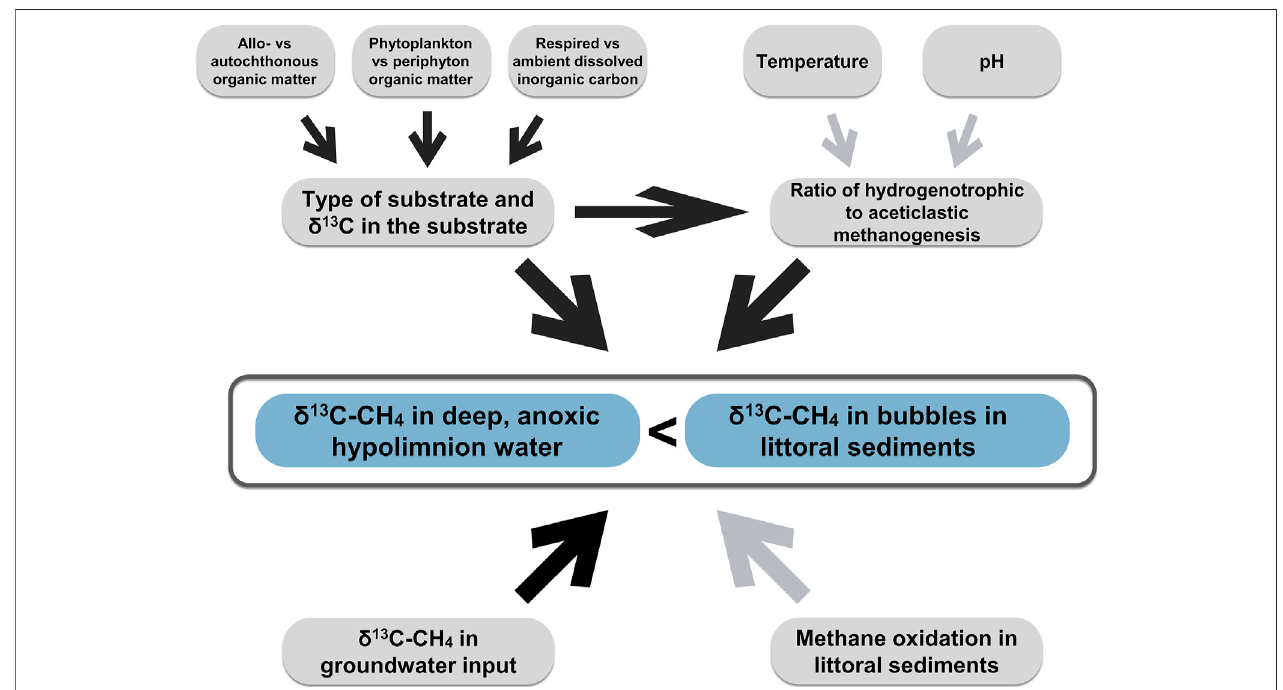
FIGURE8| Conceptual fi guresummarizingthedifferentprocessesdiscussedinthetextaspotentialexplanationsfortheobservedvariabilityin δ 13 C-CH 4 between the anoxic hypolimnion water and the littoral sediments of lakes. Dark arrows indicate relations supported by our measurements. Light arrows indicate relations that are not supported by our observations. See text for